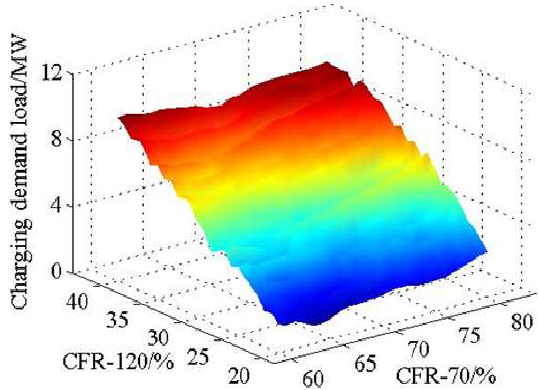
Figure 18. Charging load peak under different Charging Facility Ratio conditions.